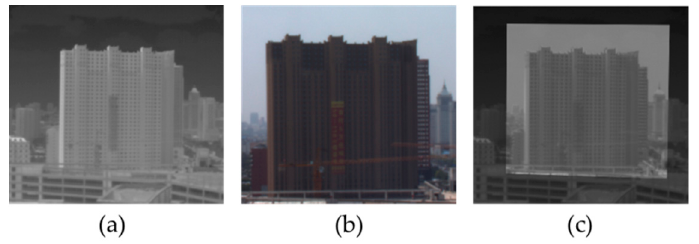
Figure 3. Registration effect. ( a ) Infrared (IR) image; ( b ) Visible image; ( c ) Registered image.